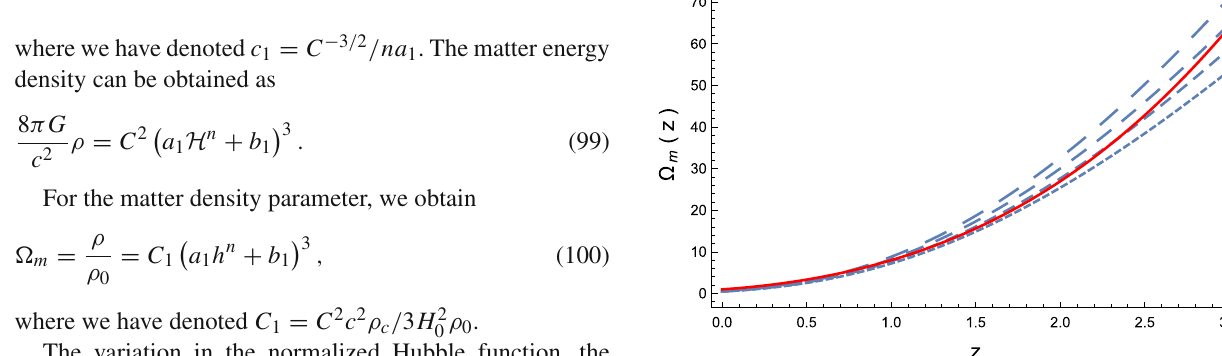
Fig. 3 Variation in the total matter density parameter (cid:15) m as a function of the redshift z for η( z ) = a 1 h n ( z ) + b 1 for n = 2 / 3, b 1 = − 0 . 21, c 1 = 3 . 9, and different values of a 1 : a 1 = 0 . 348, (short dashed curve), a 1 = 0 . 350 (dashed curve), a 1 = 0 . 352, (long dashed curve), and a 1 = 0 . 354, (ultra-long dashed curve), respectively. The red solid line represents the prediction of the (cid:2) CDM model